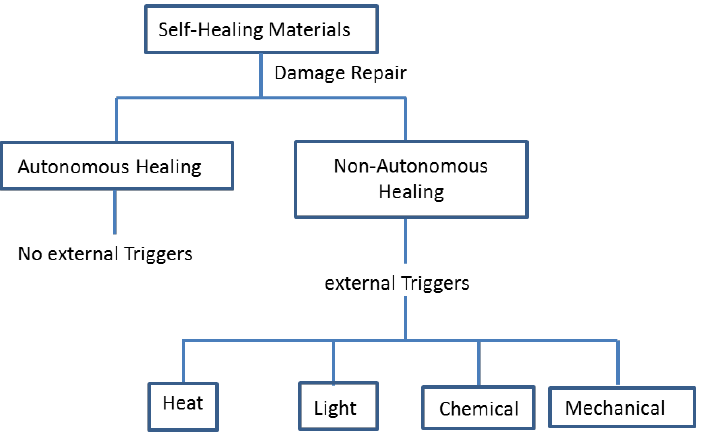
Figure 8. Illustrate the difference between autonomic and non-autonomic self-repairing process. The concept has been redesign on the basis of ref. [66].